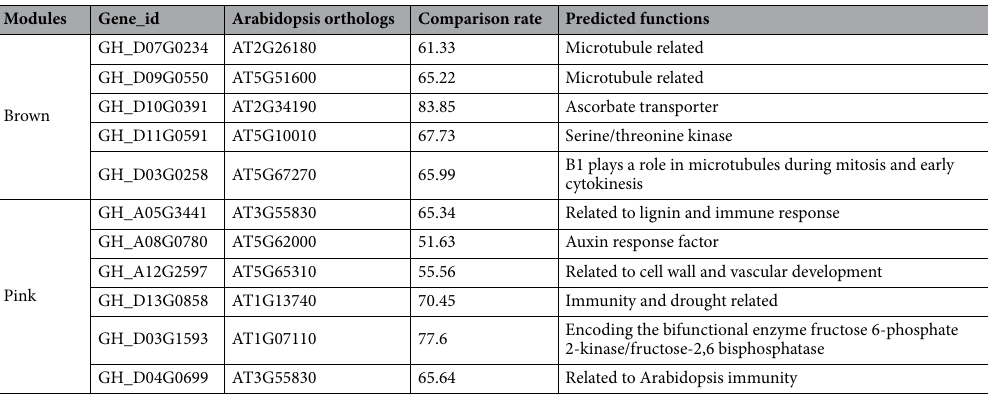
Table 2. The hub genes detected in the two WGCNA